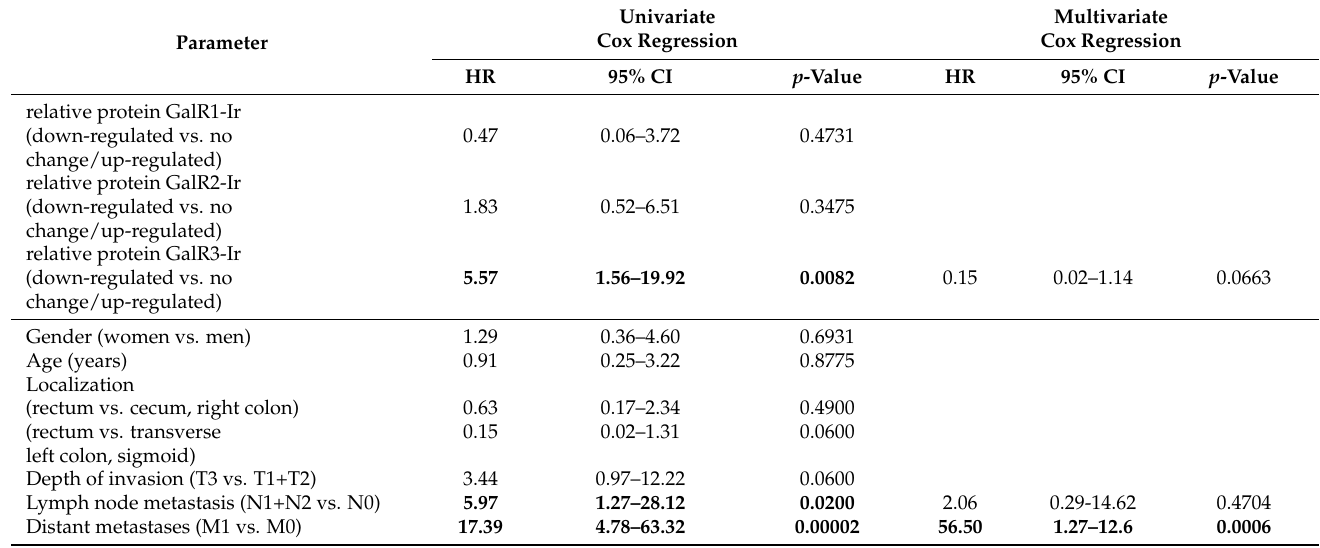
Table 2. Univariate and multivariate Cox regression analysis of the overall survival rates associated with different prognostic variables in patients with colorectal cancer (CRC).